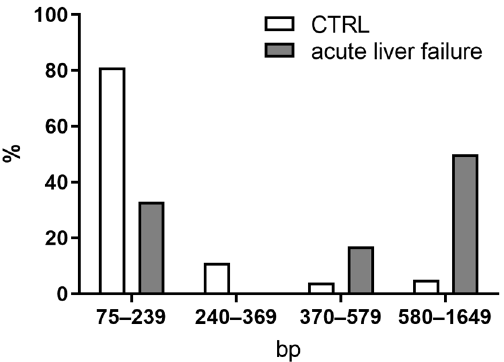
Figure 3. To assess the fragmentation profile of ecDNA, fragment lengths were analyzed to compare control and acute liver failure groups.